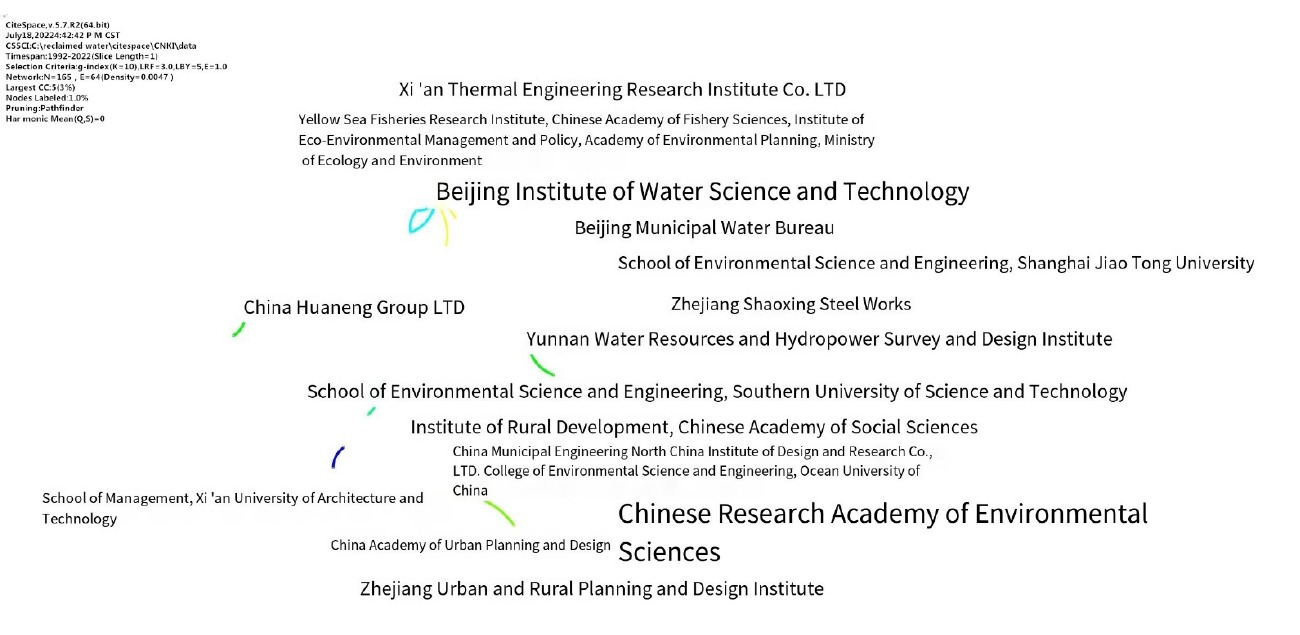
Figure 6. Cooperation network of domestic institutions.